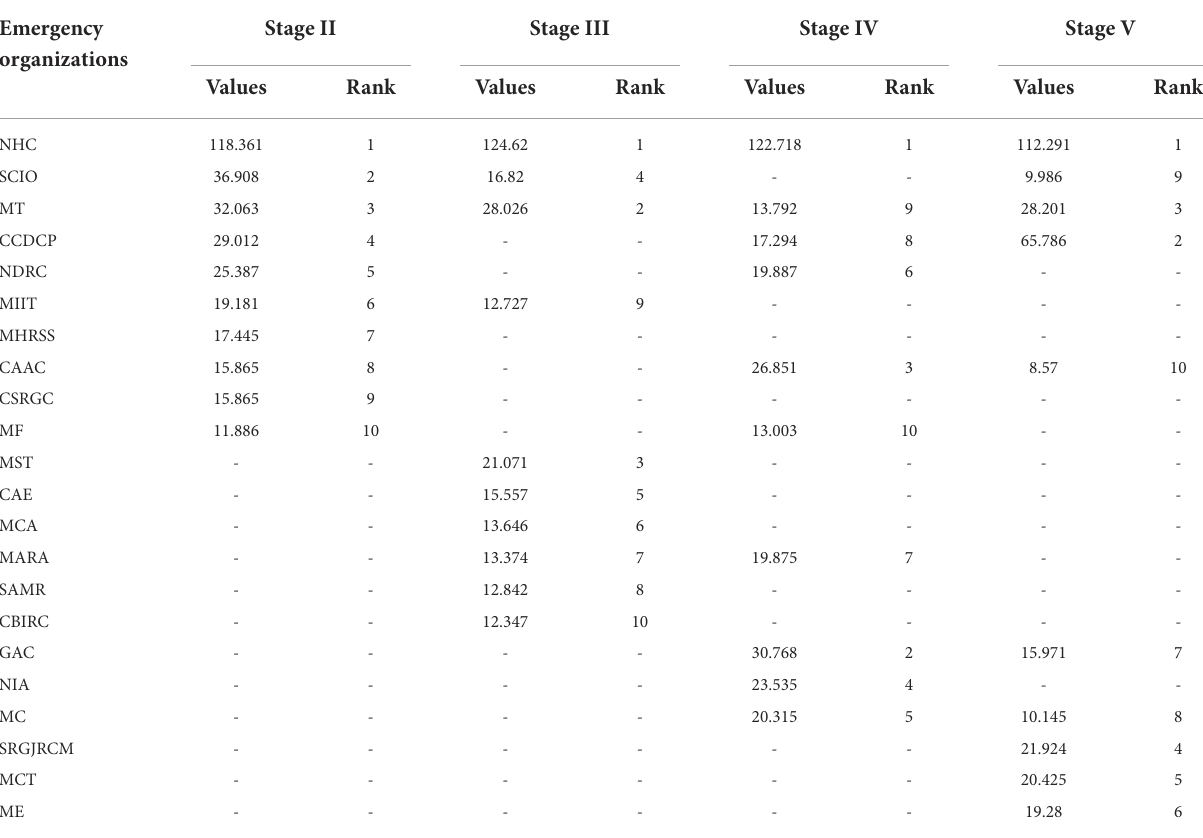
TABLE 7 Top 10 EOs with the normalized eigenvector centrality in Stages